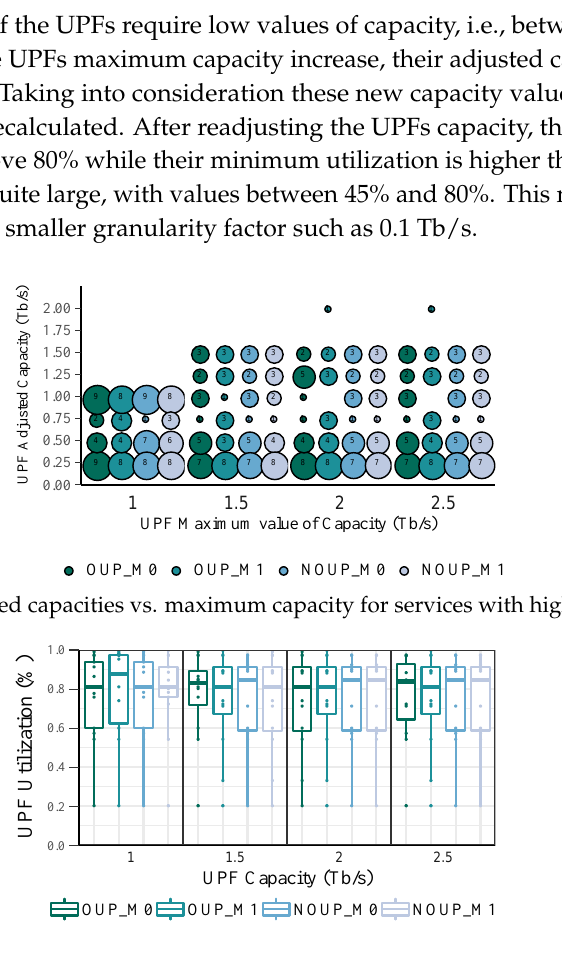
Figure 9. UPF Utilization distribution in rural scenario after adjusting their